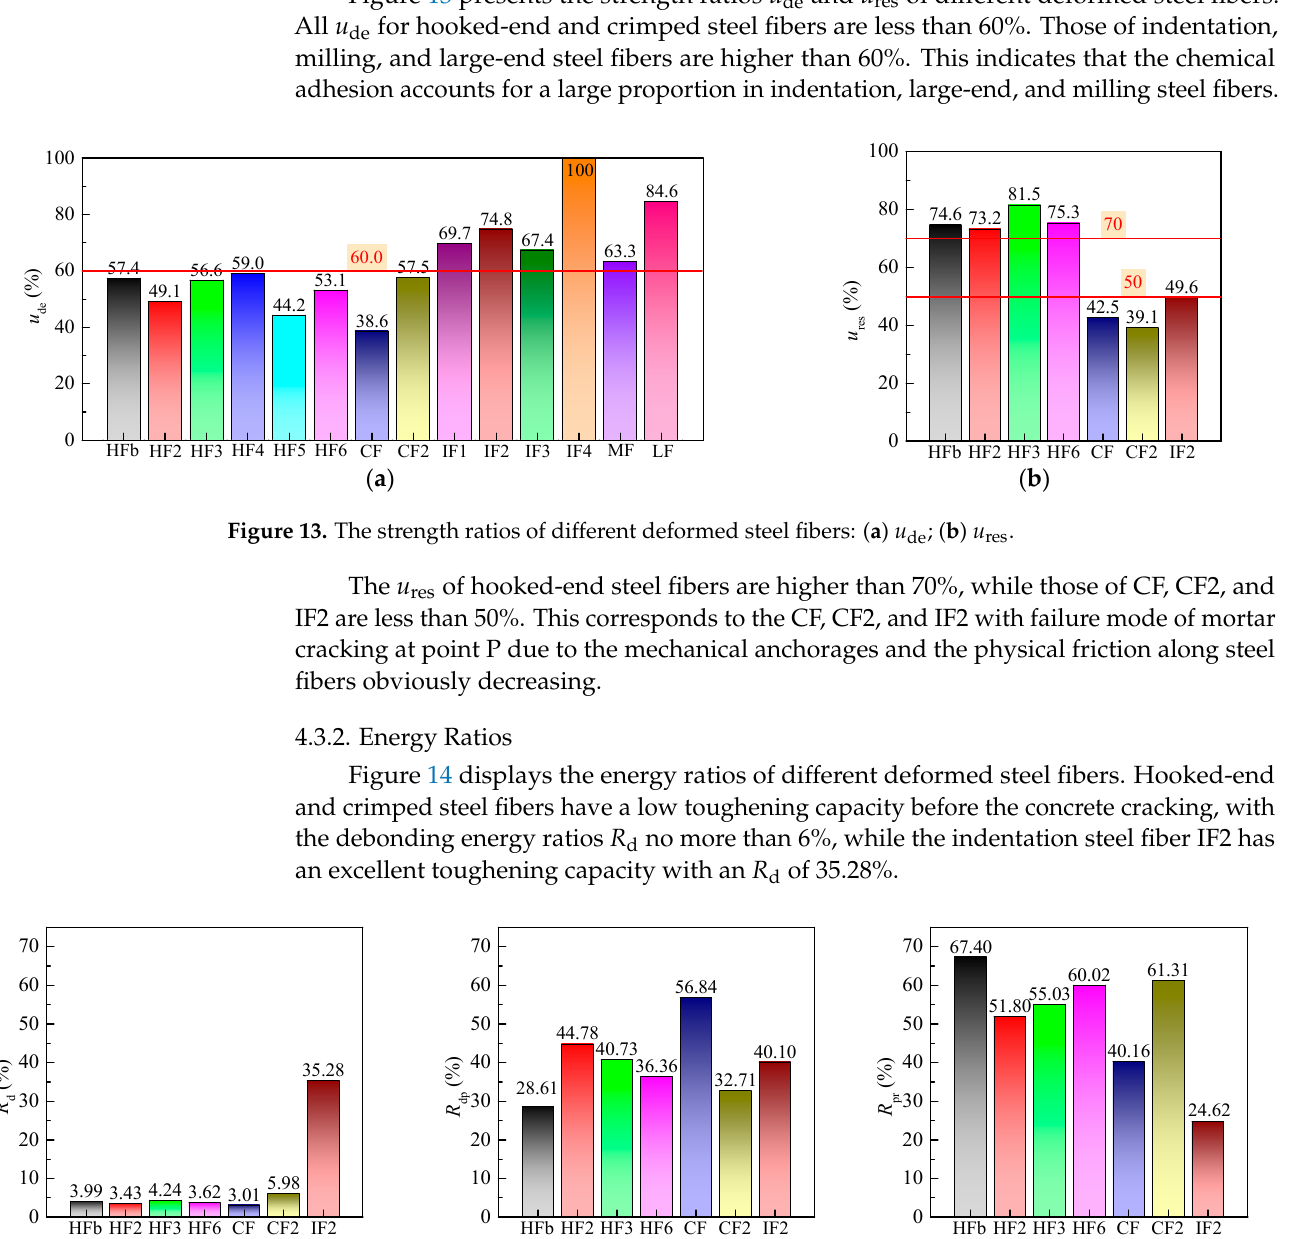
d ; ( b ) R dp ; ( c ) R pr .